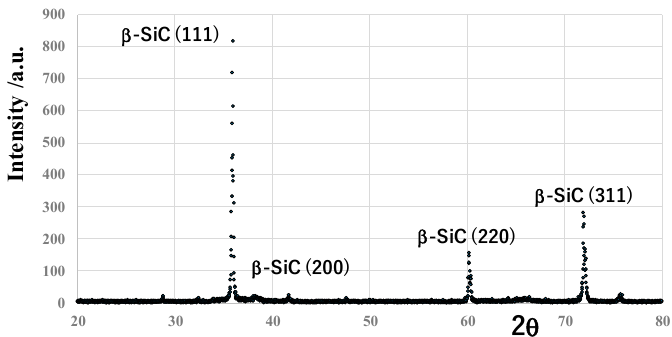
Figure 4. X-ray di ff raction (XRD) analysis on the thick SiC Figure 4. X-ray diffraction (XRD) analysis on the thick SiC coating.